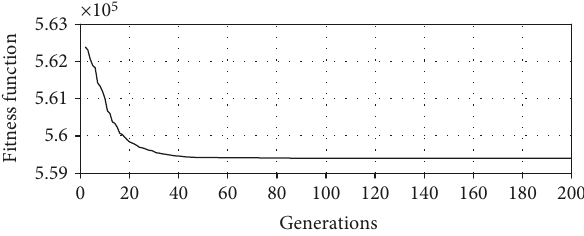
Figure 16: Evolution of the fi tness function of strategy 1 through generations.